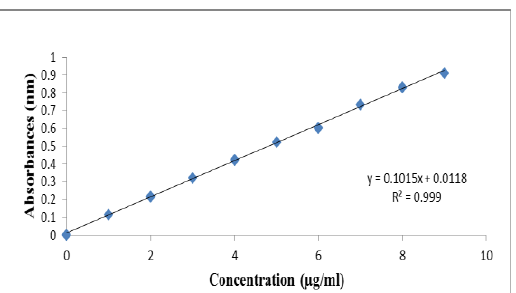
Figure (4) Calibration curve of rebamipide in phosphate buffer (pH 7.4)